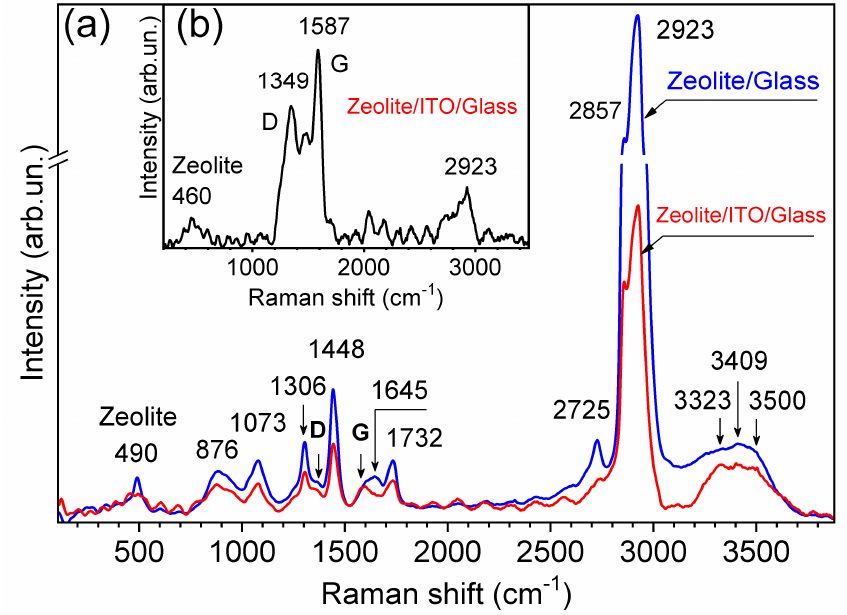
Figure 3. Raman spectra of the zeolite 3A—carbon layers ( λ Ex = 532.5 nm): ( a ) laser power of 45 mW, ( b ) laser power—15 mW. Table 1. Vibrational frequencies of the zeolite